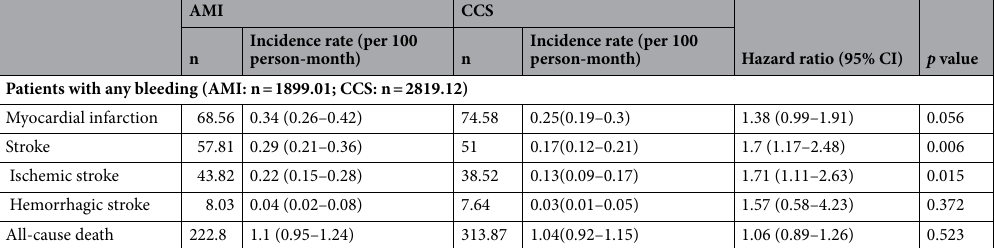
Patients with any bleeding (AMI: n = 1899.01; CCS: n = 2819.12)